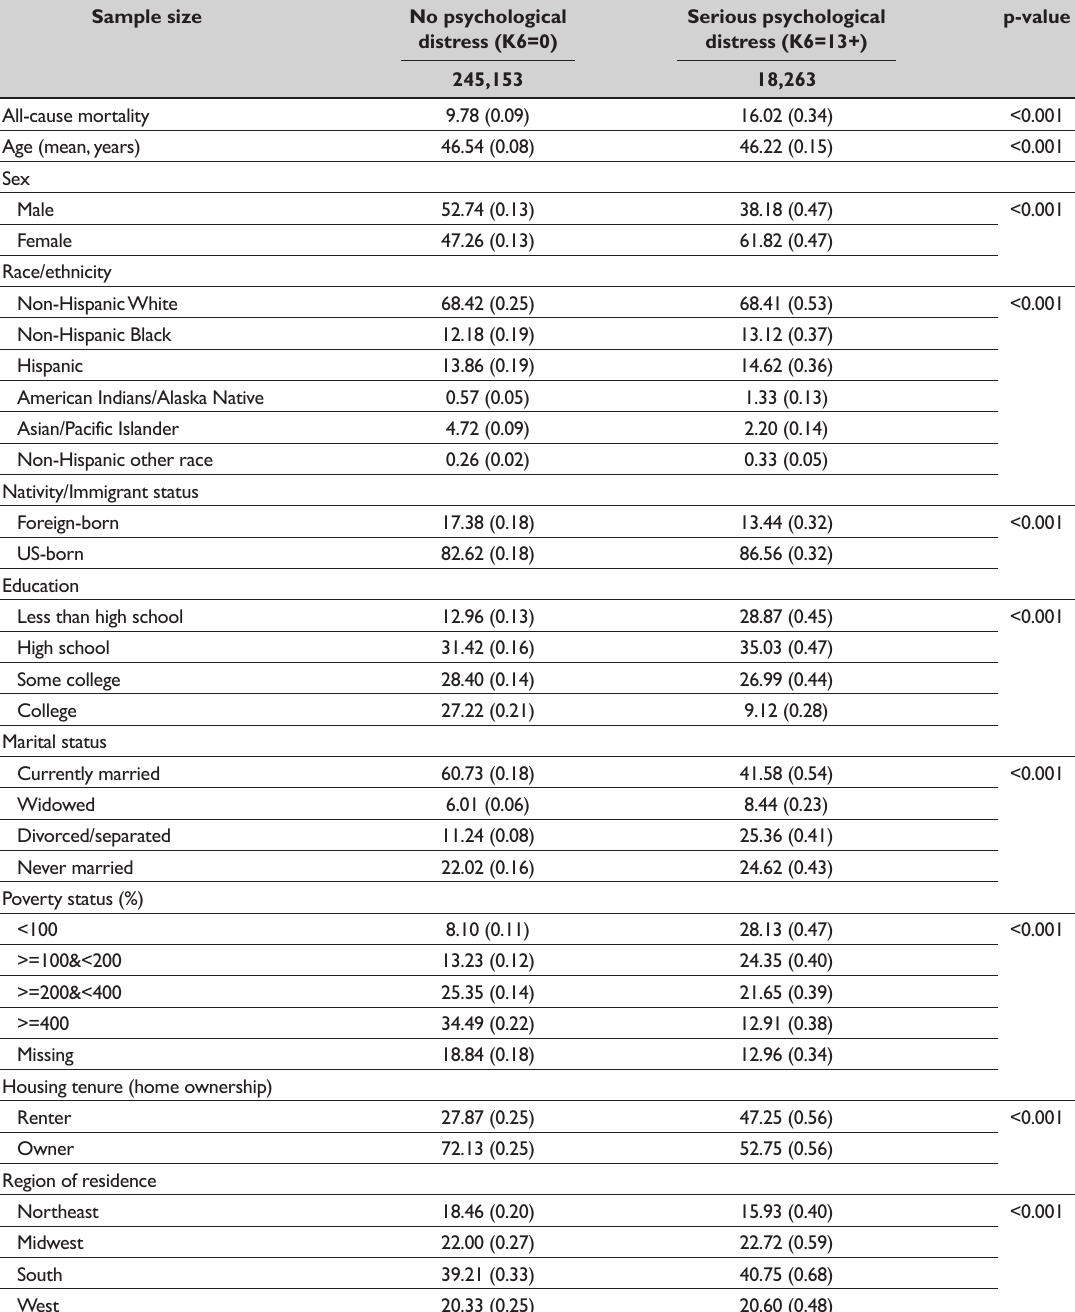
Table 1: Mortality rates (%) and individual characteristics (%) among adults aged 18 years and older by psychological distress, United States,